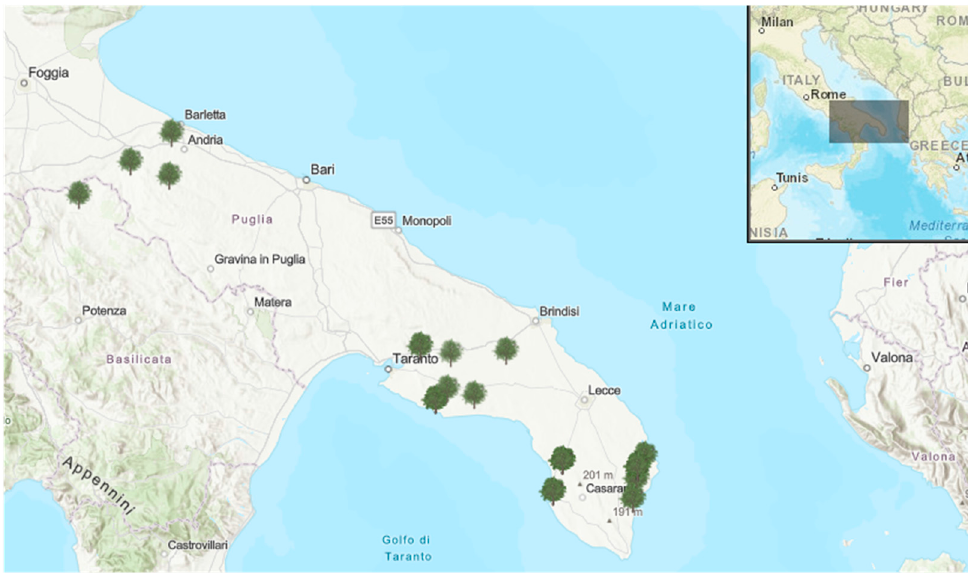
Figure 7. Expansion of Apulia region in Italy. Sample areas are showed by the tree